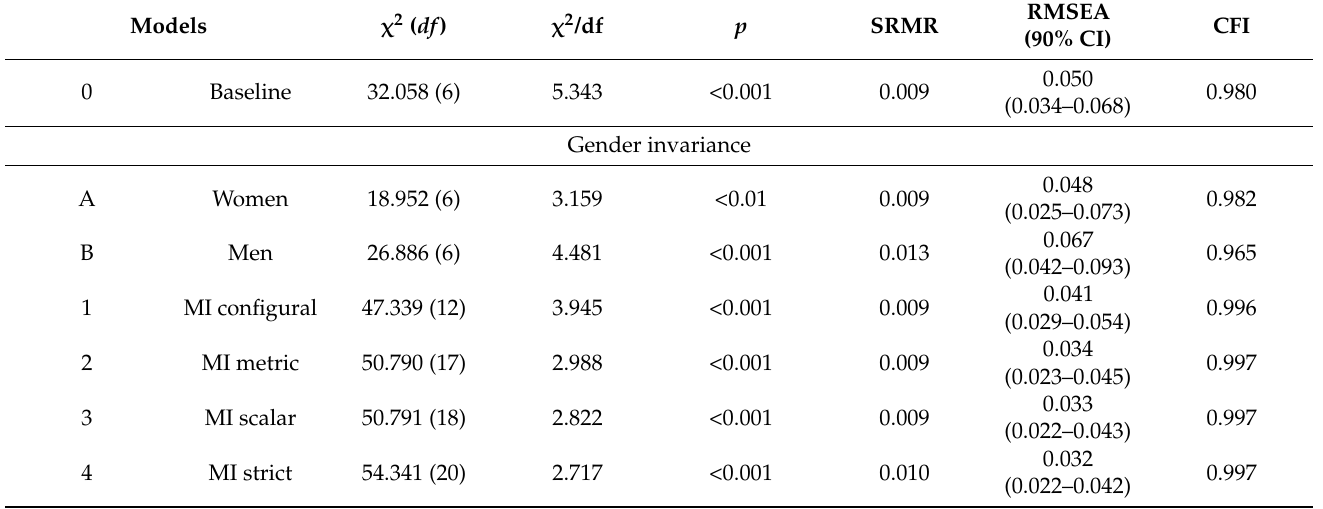
Table 5. Results of the multigroup confirmatory factor analysis to examine measurement invariance across genders and